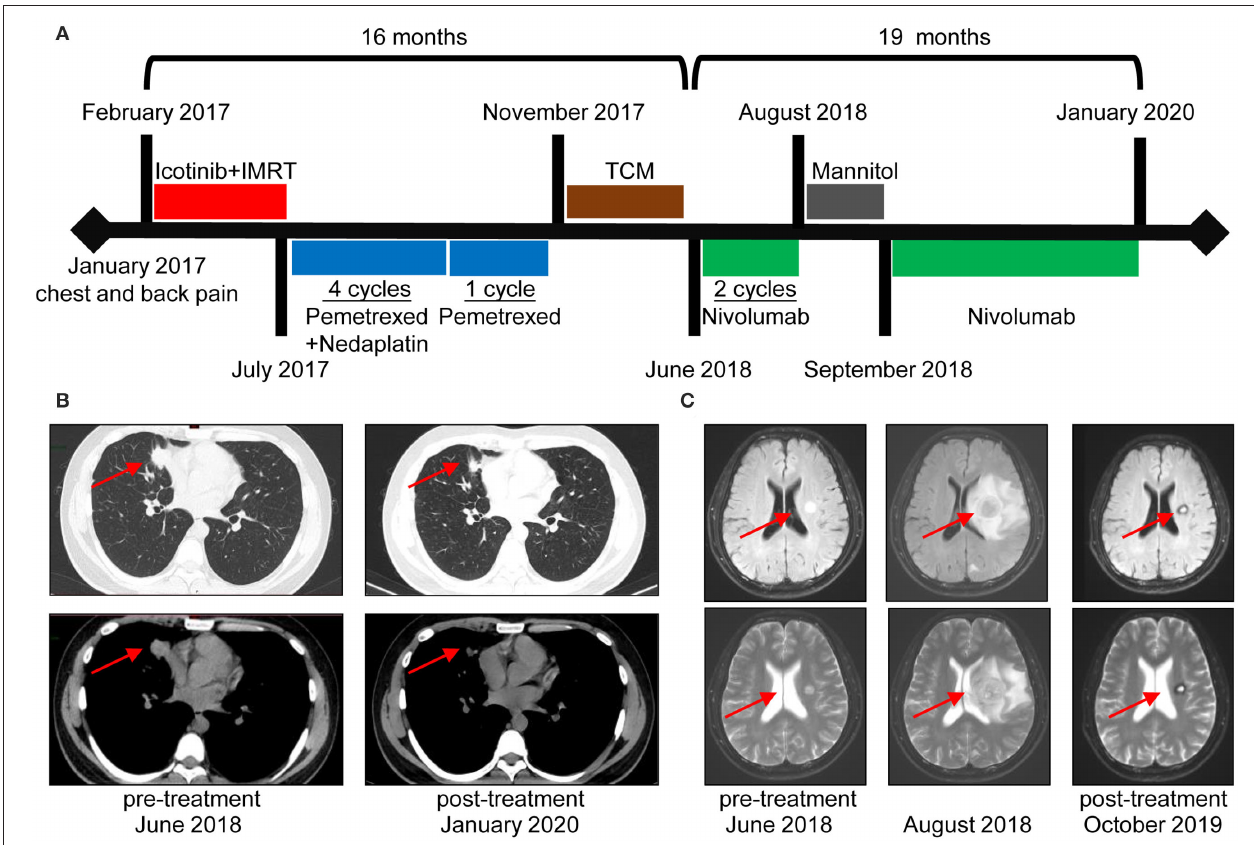
FIGURE 1 | Durable clinical response to Nivolumab in a non-small cell lung cancer (NSCLC) patient with epidermal growth factor receptor ( EGFR ) driver mutations. (A) Clinical timeline of patient, with major treatment indicated. The patient has been benefitting from immunotherapy for more than 19 months. (B) Chest computed tomography (CT) of the metastatic lung tumors before Nivolumab initiation (June 2018) and last time follow-up (January 2020). (C) Magnetic resonance imaging (MRI) before and after Nivolumab treatment. Images in the middle revealed an increased size of the left basal ganglia lesion accompanied by edema and multiple